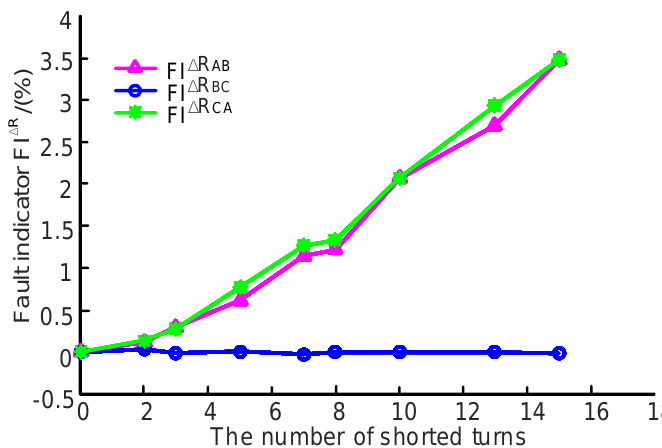
Figure 9. FI ∆ R under different numbers of the shorted turns. In addition, the fault indicator of the line-to-line inductance FI ∆ L can be calculated through Equation (19), and the calculation results are drawn as the curve shown in Fig- ure 10, where FI ∆ L increases from 0% to 16.4%, which changes significantly compared to the resistance fault indicator FI ∆ R .